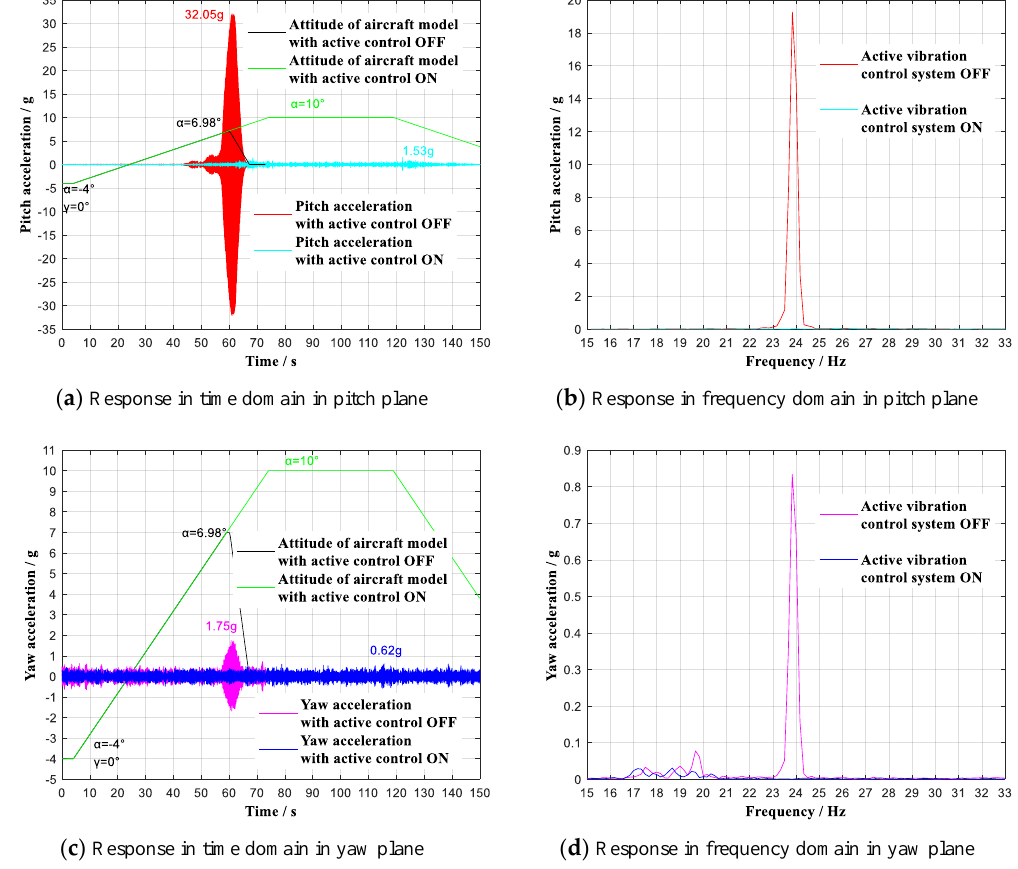
Figure 11. Vibration with multidimensional vibration suppression system on and off lifting continuous (γ = 0°) at 0.6 Ma. ( a ) Response in time domain in pitch plane; ( b ) Response in frequency domain in pitch plane; ( c ) Response in time domain in yaw plane; ( d ) Response in frequency domain in yaw